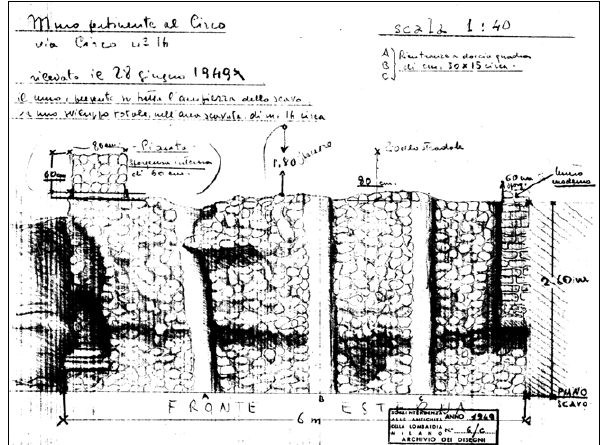
Figure 3. Drawing of an archaeological excavation carried out